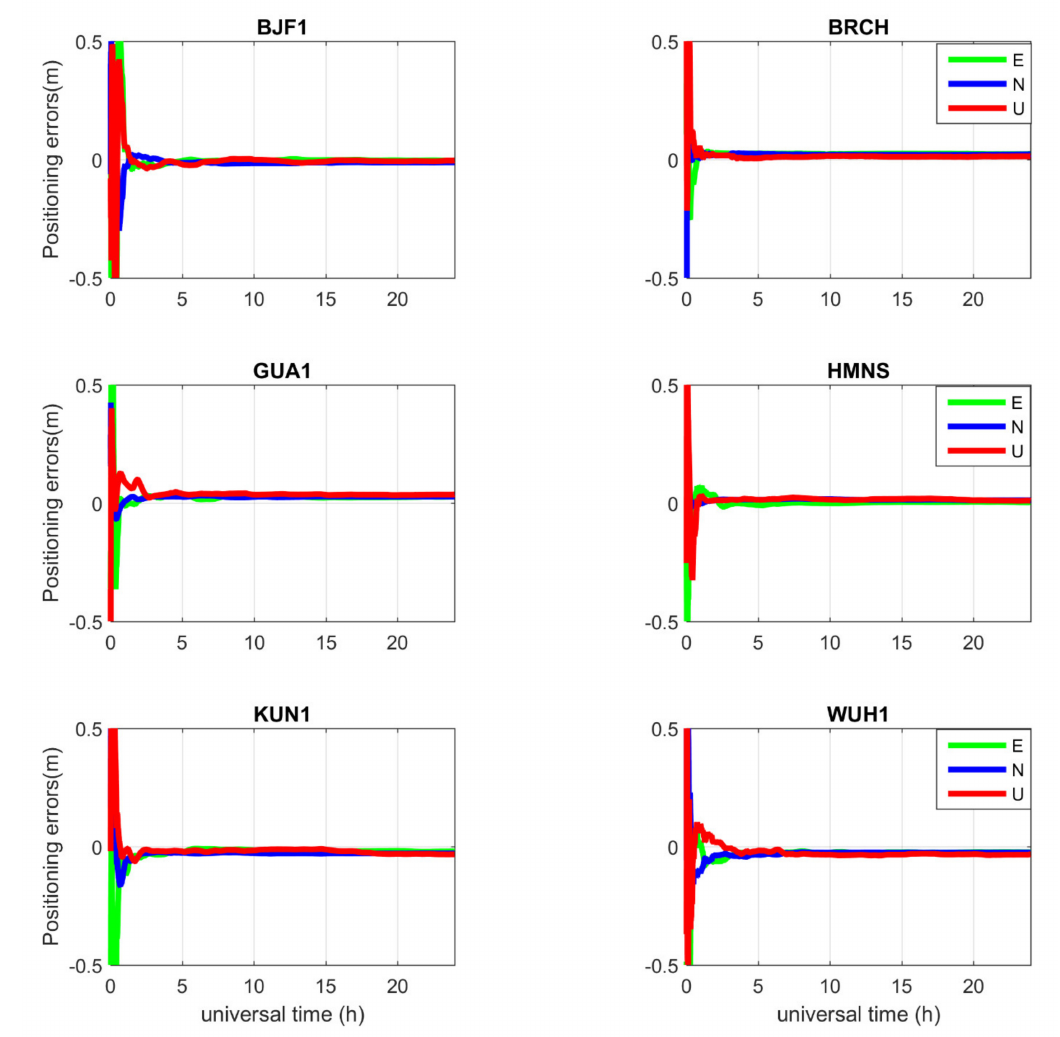
Figure 21. Positioning errors of B1I/B3I PPP without DCB correction at six